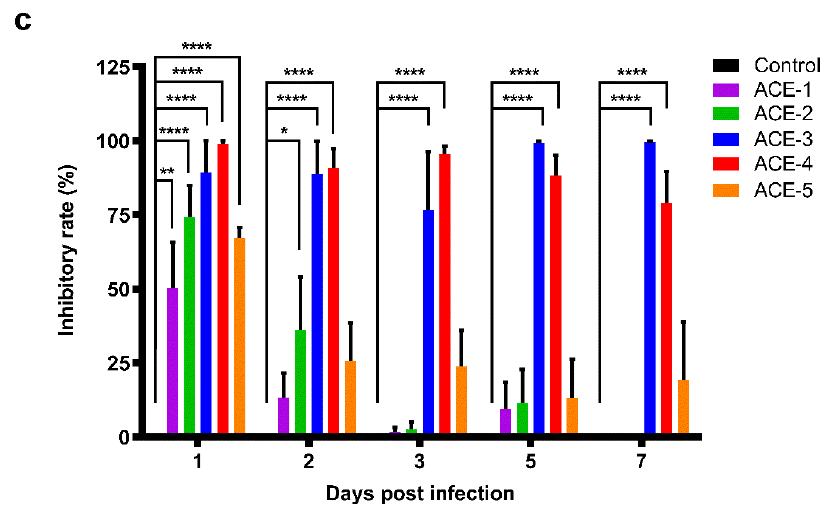
Figure 2. Both ACE-3 and ACE-4 could significantly inhibit DENV replication. ( a ) Replication curve of DENV in Meg-01 cells, and the peak of the titer was showed at day 5 post infection. ( b ) The viral titers of DENV in the A. cinnamomea extracts-treated Meg-01 cells. ( c ) The inhibitory rate of the A. cinnamomea extracts against DENV infection in Meg-01 cells. All the values represent as mean ± SEM of three experiments. p values were calculated using two-way ANOVA, statistically significant difference * p < 0.05, ** p < 0.01, **** p < 0.0001.